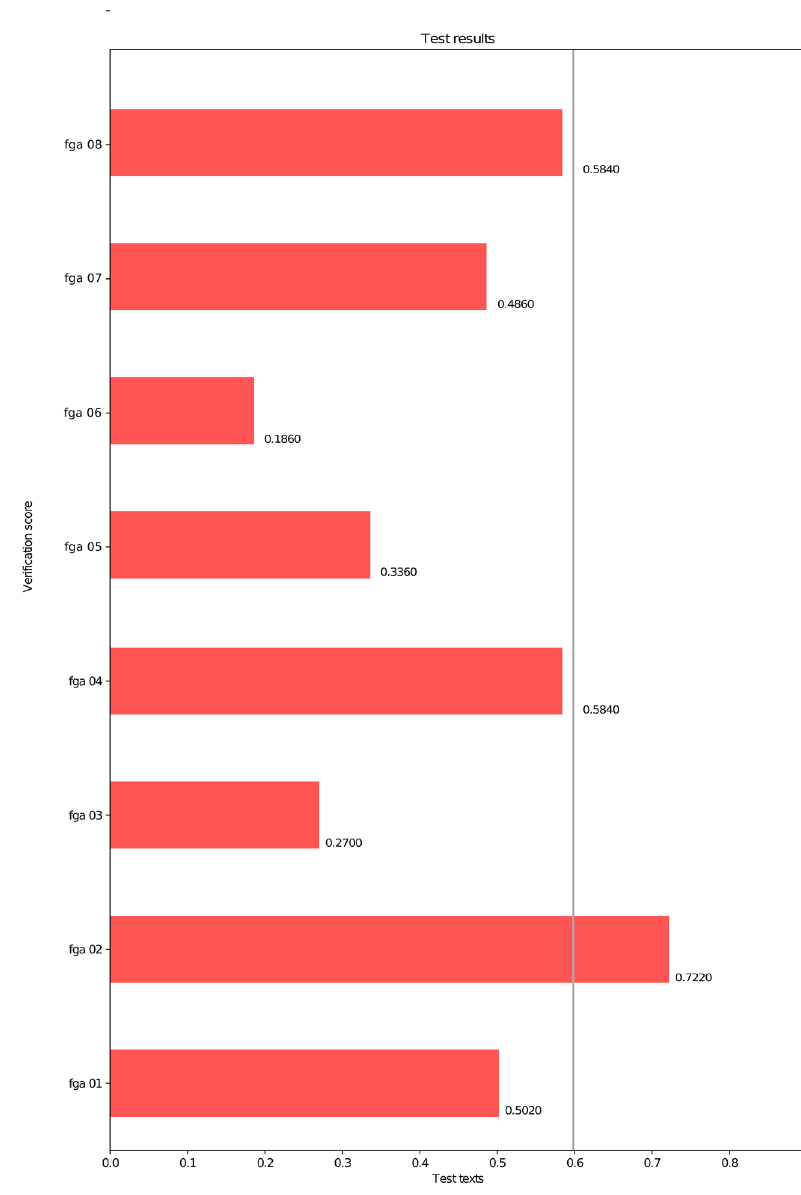
Fig. 3 Test set results for sample texts from FgA 1772 longer than 2100 characters where authorship is regarded as not verified, disputed or unclear